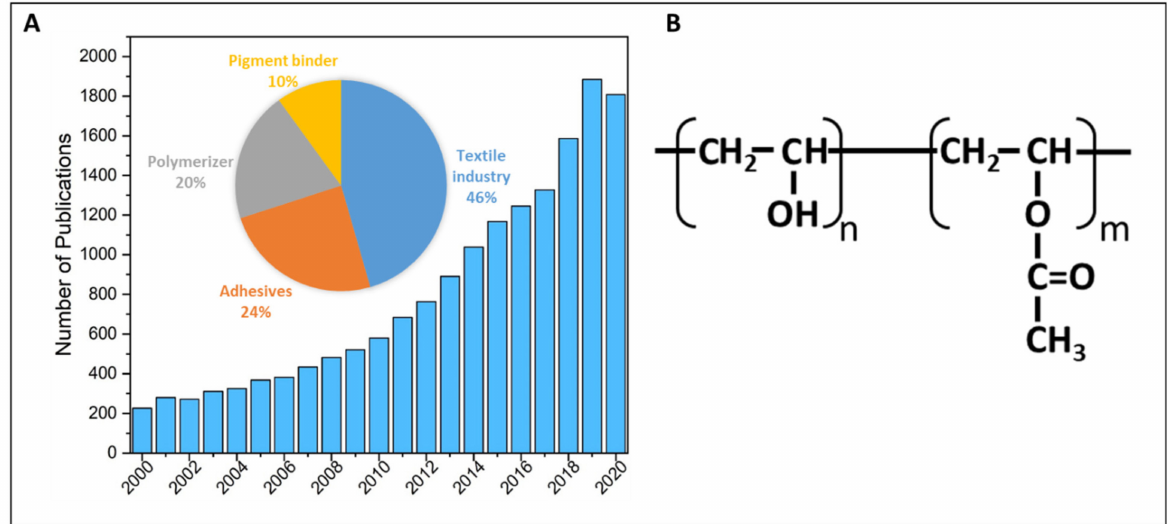
Figure 1. ( A ) Increasing number of publications per year focusing on polyvinyl alcohol (PVA) as well as a pie chart depicting percentage distribution of PVA applications [3] and ( B ) the chemical structure for partially hydrolyzed polyvinyl